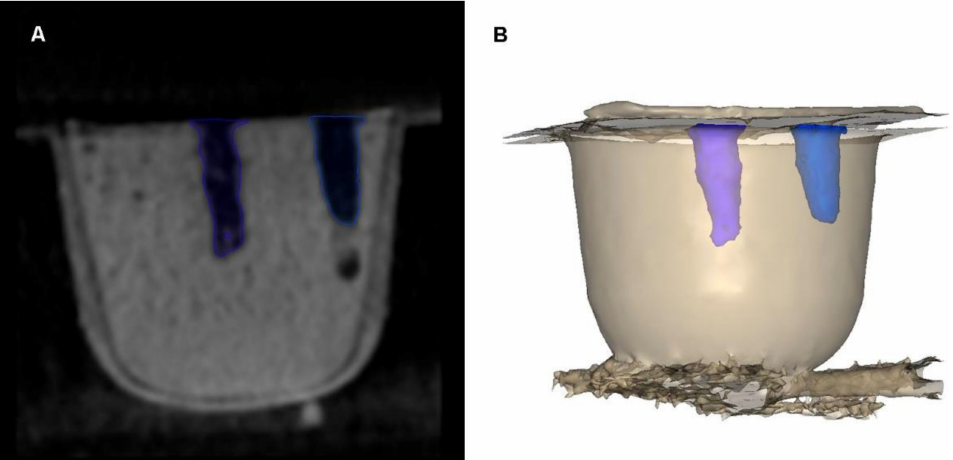
Figure 6. ( A ) The osteotomy site preparations were submitted to a CBCT scan that was segmented to analyze the ( B ) osteotomy site preparation